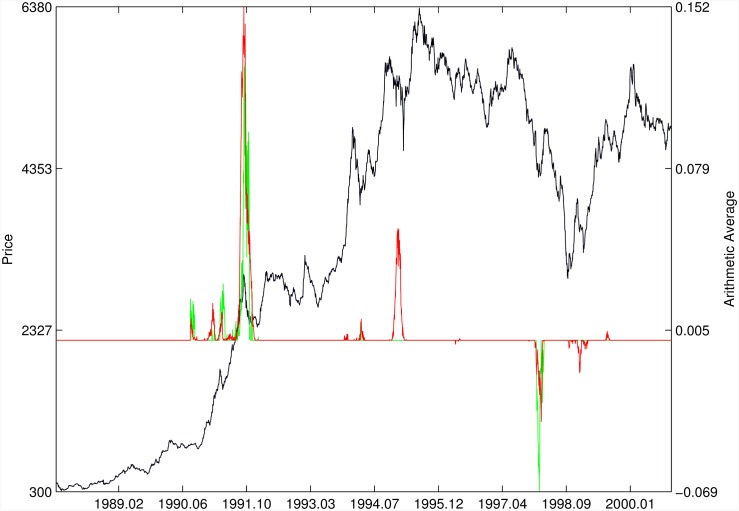
Chile 1991/1994.Same as Fig 10.